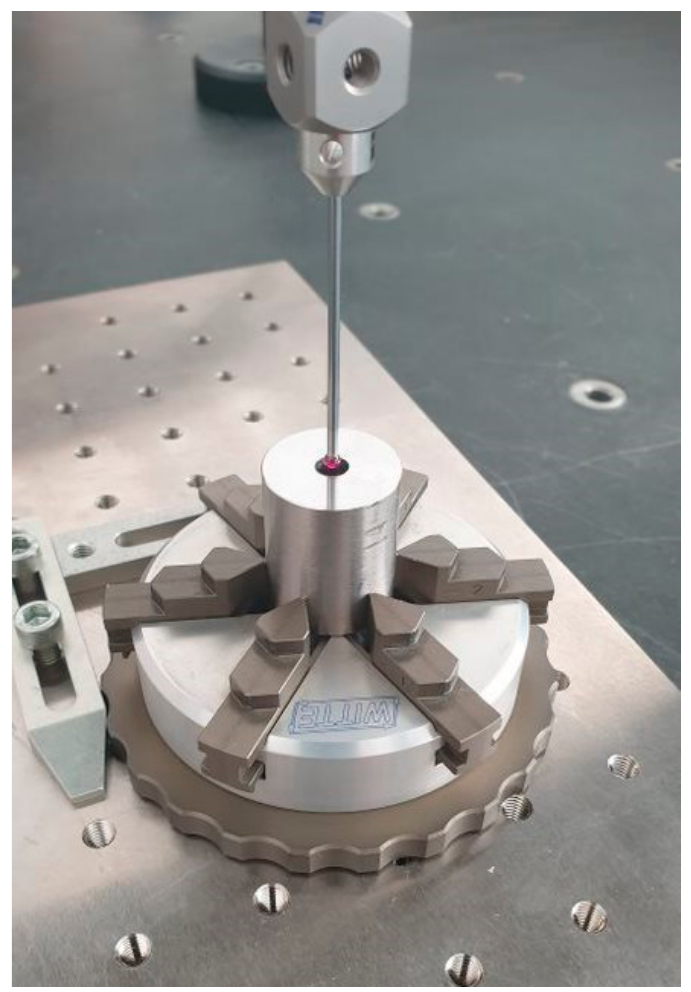
Figure 4. Workpiece clamping in the PRISMO Navigator coordinating machine.